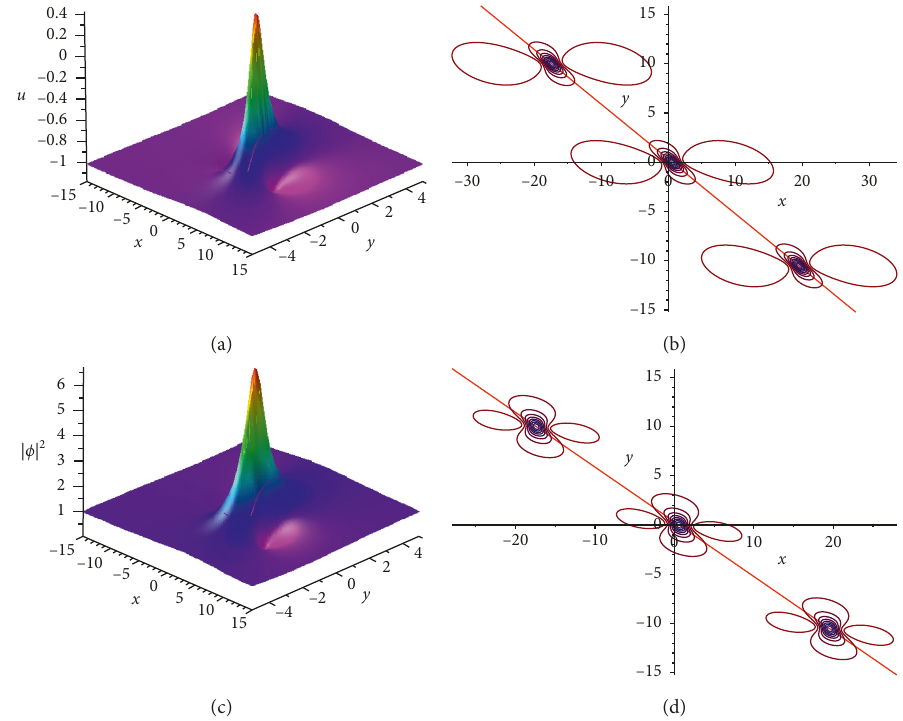
Figure 1: Lump solution (2) with (5) and (7) taking parameters a lump wave of u at t lump wave of